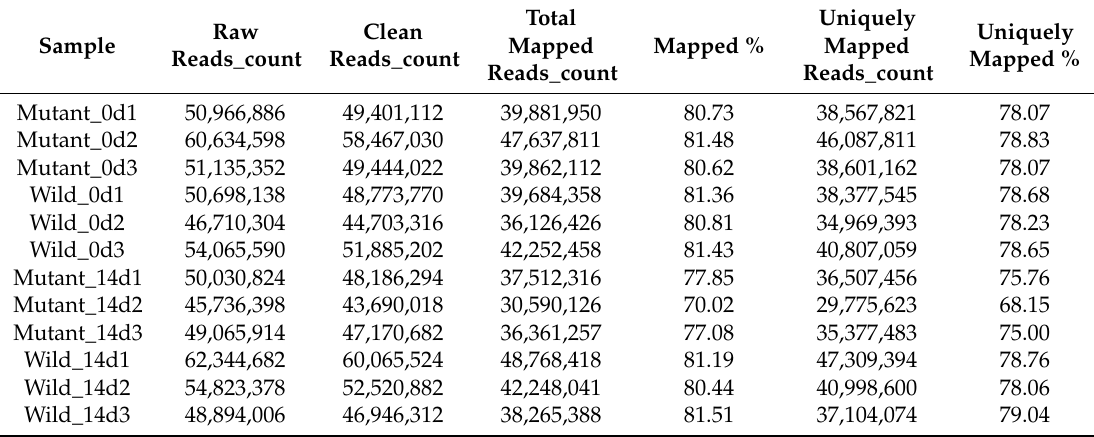
Table 2. Overview of the RNA-sequencing reads generated from each sample.